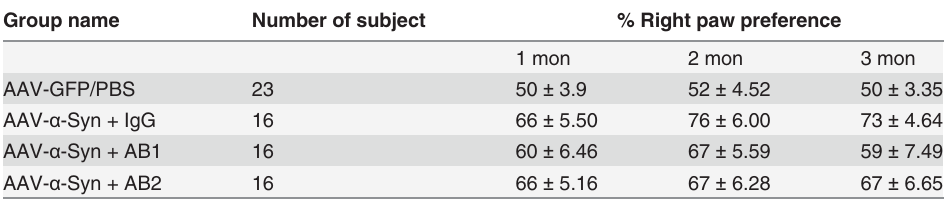
Table 1. Paw preference for all groups.